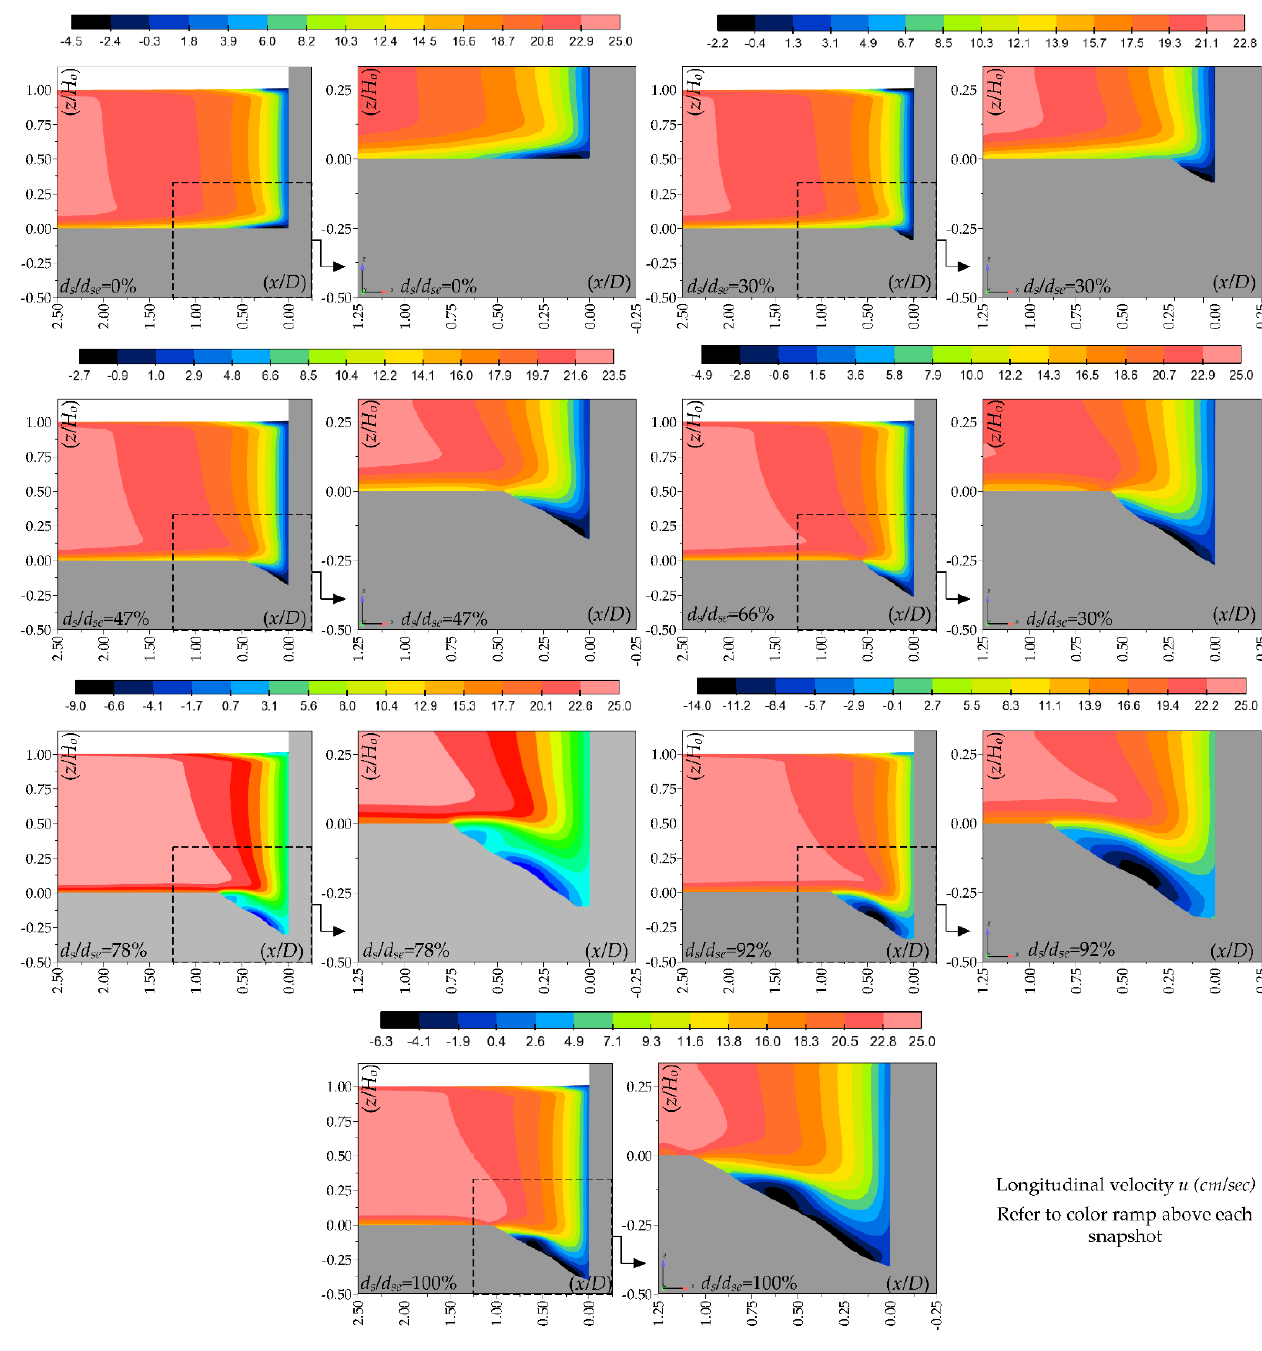
Figure 9. Simulated longitudinal velocity 𝑢 .